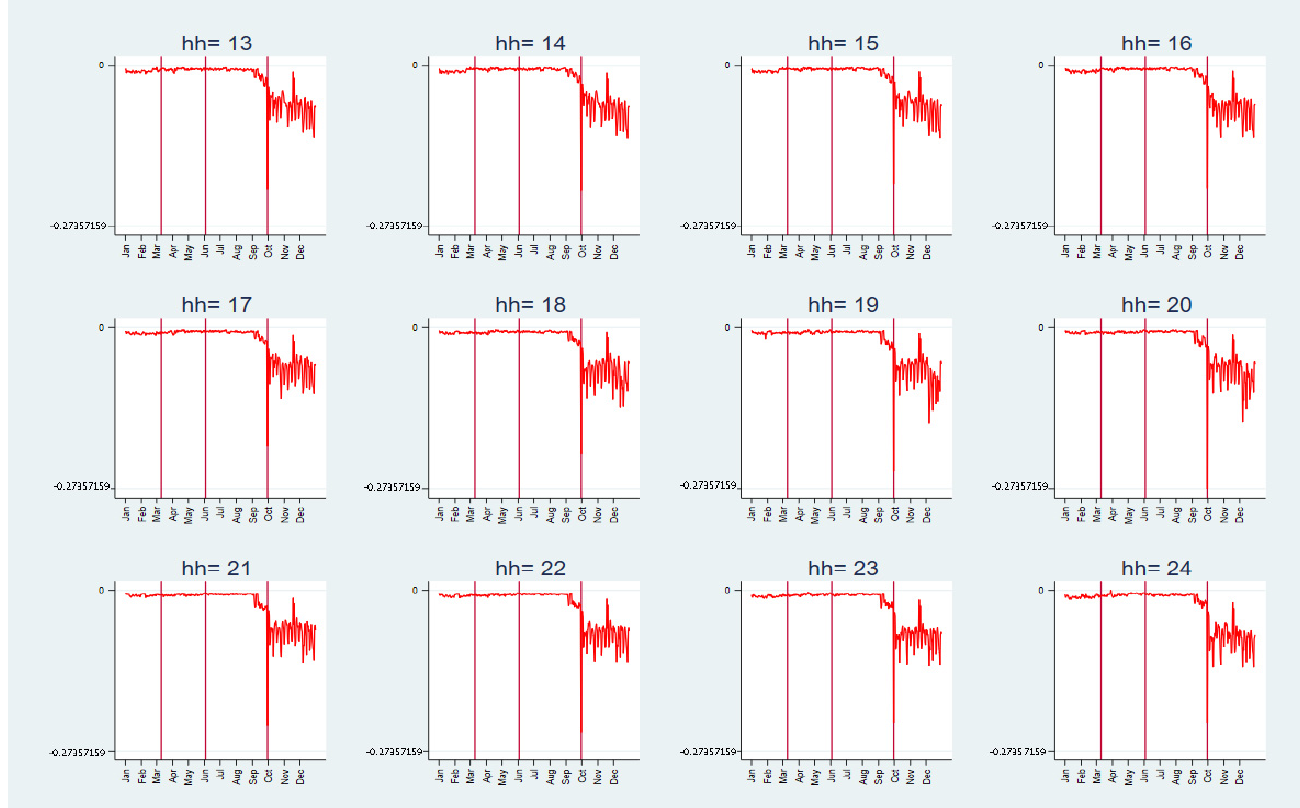
Figure 8. Hourly elasticity estimates for the hours 1 p.m.–12 p.m., 2020 .